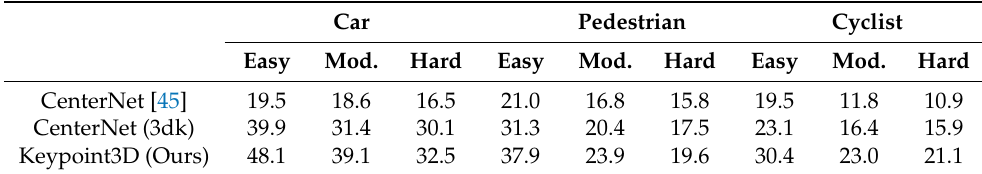
Table 3. 3D object detection accuracy comparison of the baseline work and Keypoint3D in car, pedestrian, and cyclist categories. The average precision ( AP 3 D ) (in %) of 3D object detection is evaluated as per the KITTI val set ( IoU = 0.5).